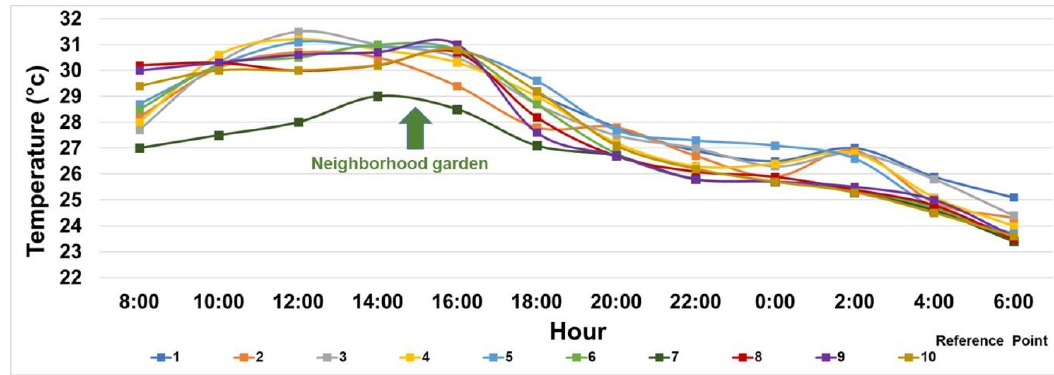
Figure 6. An hourly cross-section at 20–21 June, 2019, according to measuring points in Hizkiyahu St. (every line displays the temperature at a selected point around the clock). Line 7 (dark green) represents the neighborhood garden.